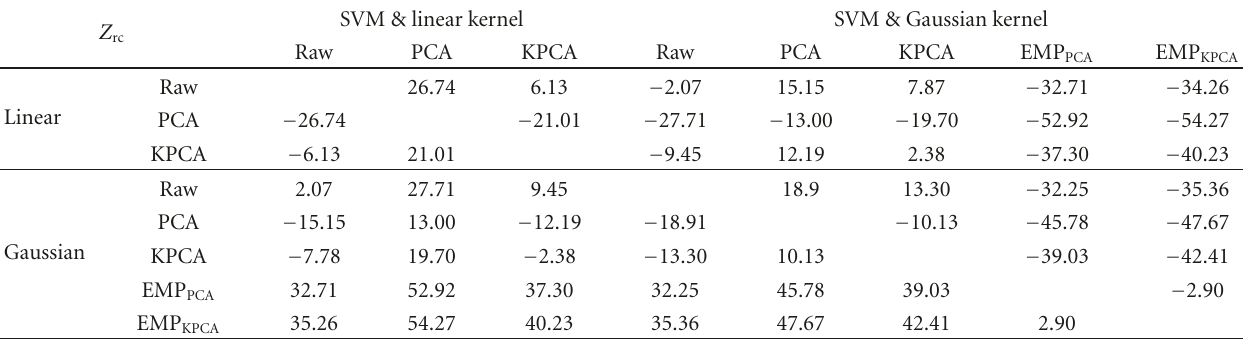
Table 9: Statistical significance of di ff erences in classification ( Z ) for the Pavia center data set. Each case of the table represents Z rc where r is the row and c is the